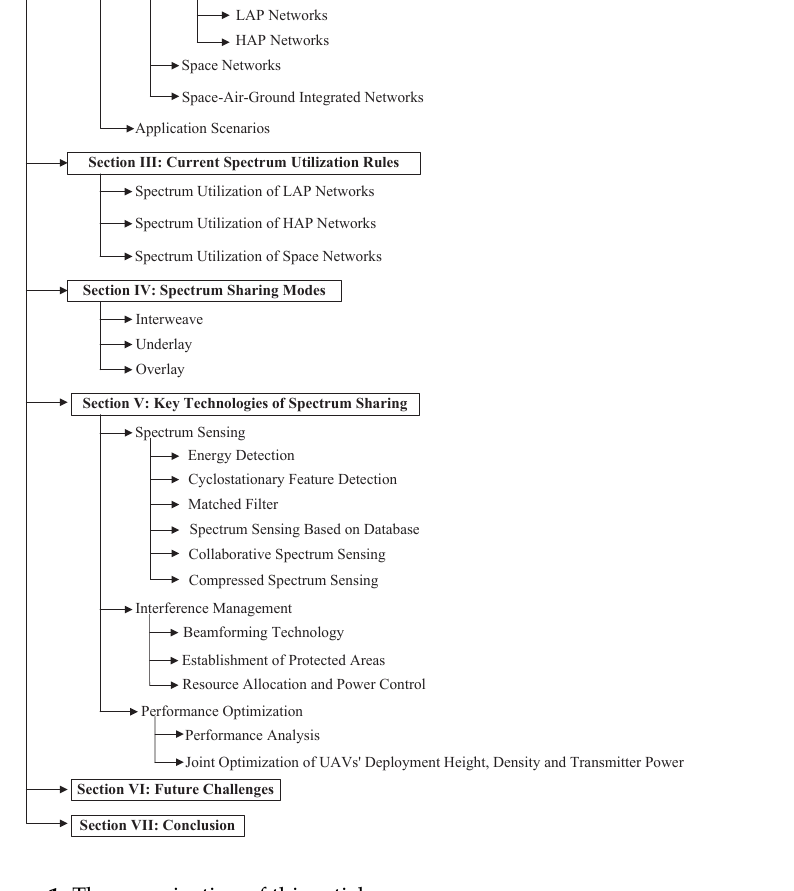
Figure 1. The organization of this